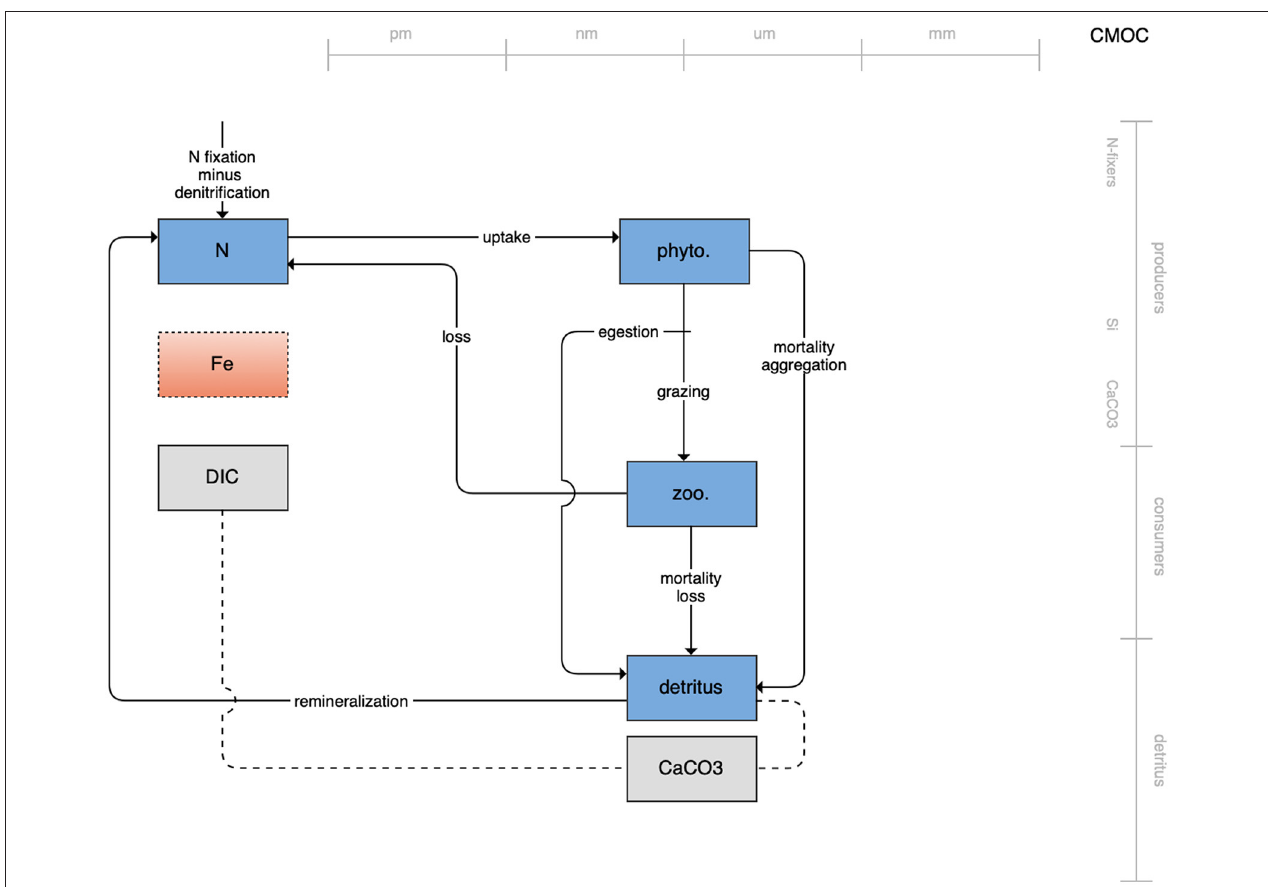
FIGURE 2 | Schematic for the CMOC model. See Figure 1 caption for